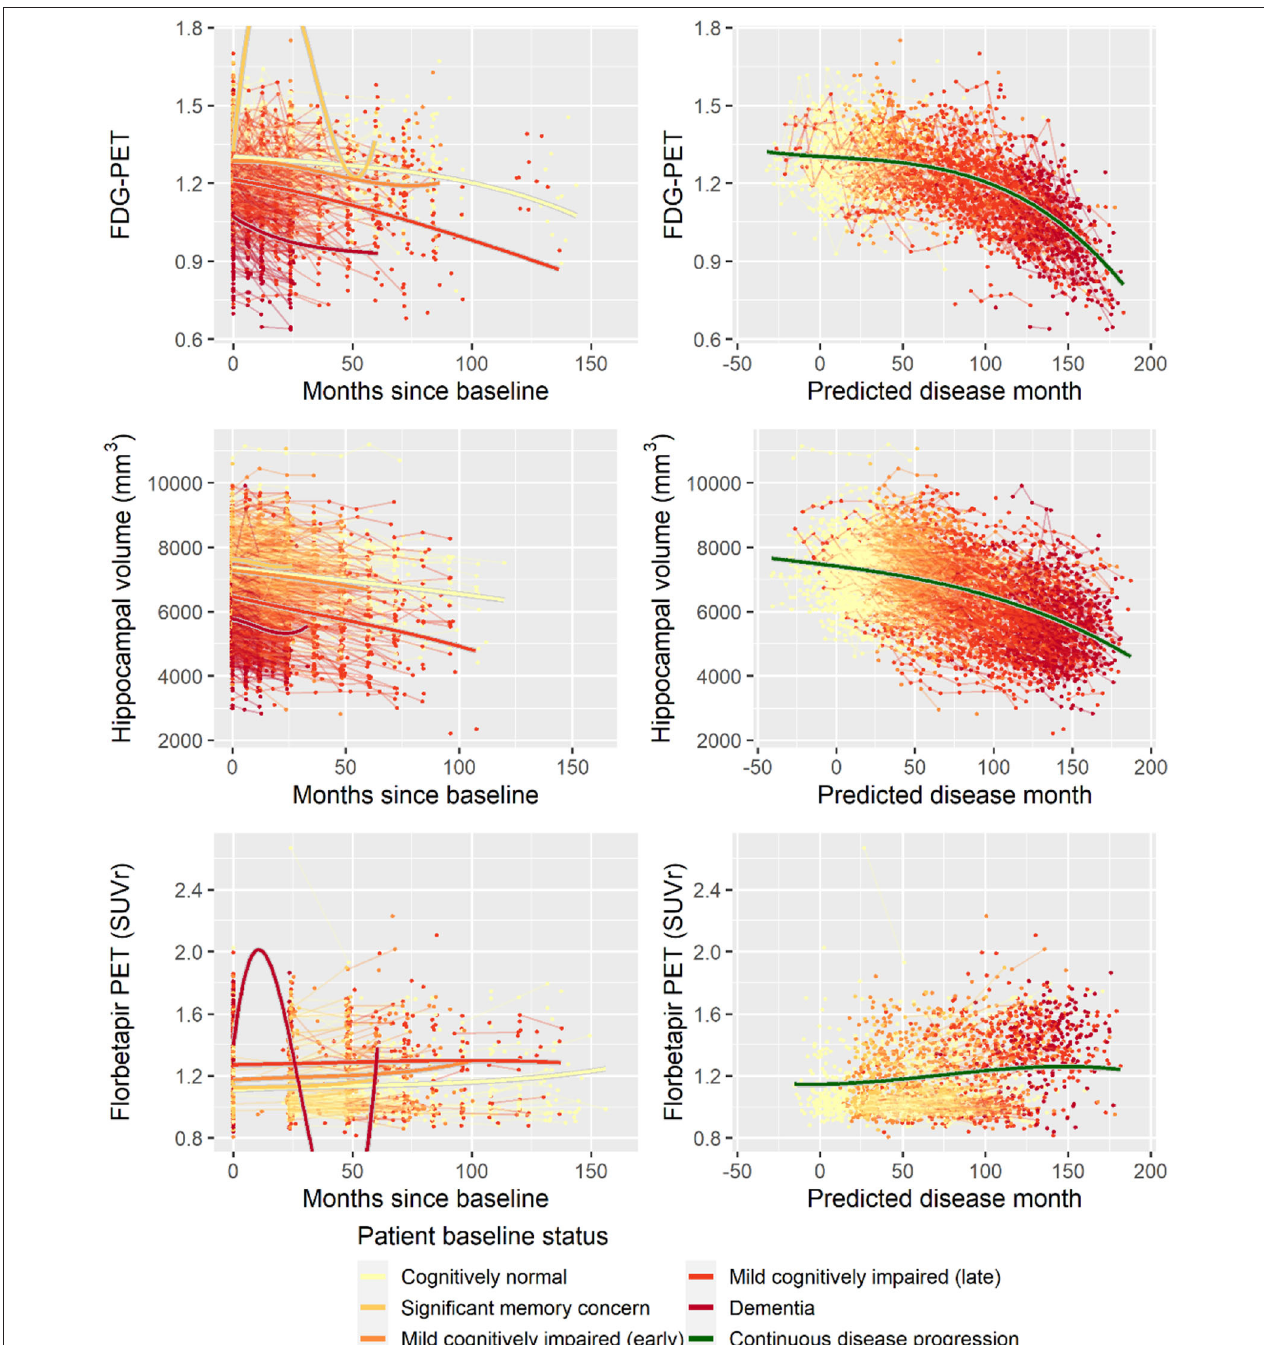
FIGURE 4 | Data and estimated biomarker trajectories for FDG-PET, hippocampal volume (MRI), and florbetapir PET. Left column shows results when allowing different trajectories for the five baseline groups; right column shows the results when requiring a single trajectory over predicted disease time. Note that the oscillations for the significant memory concern and dementia groups on FDG-PET and florbetapir PET, respectively, occur in time periods where no data were collected for these